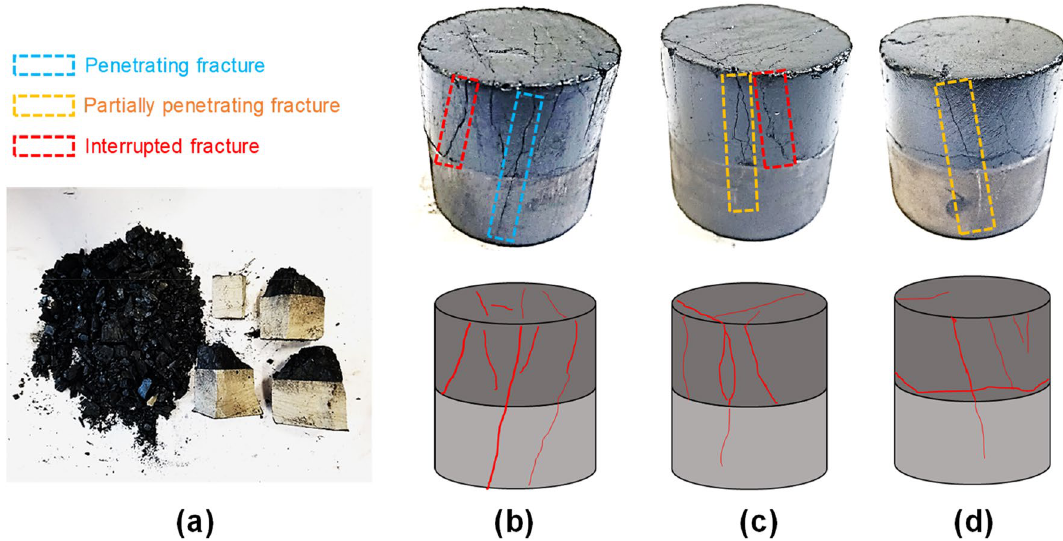
Figure 16. Failure mode and crack propagation in combined samples under different confining pressure. ( a ) unconfined, ( b ) 5 MPa, ( c ) 10 MPa, ( d ) 15